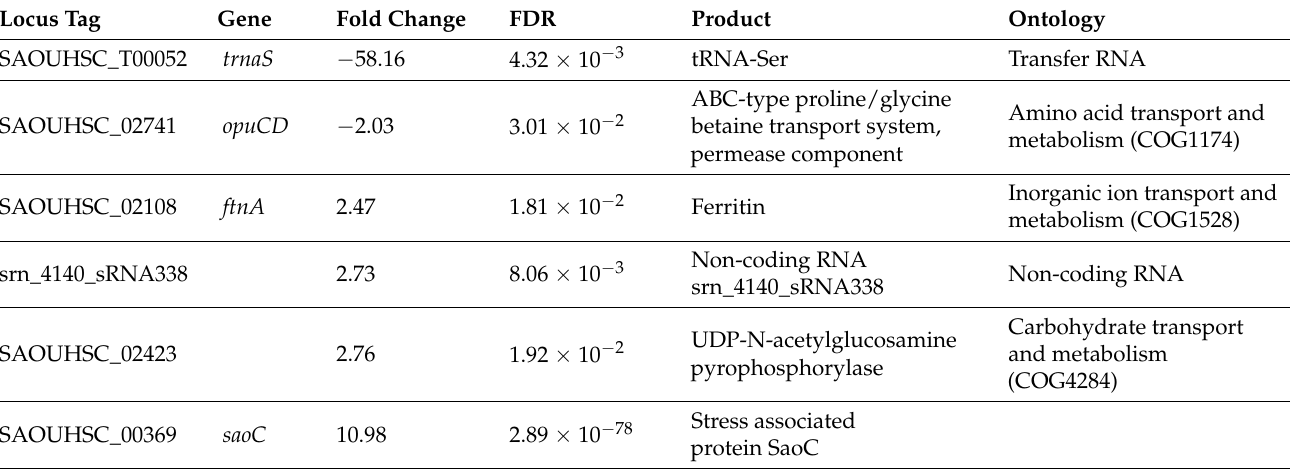
Table 2. Transcripts differentially expressed in RN4220 ∆ saoC mutant in the late growth phase. Transcripts are sorted in respect to the fold change value. Negative values indicate fold-decrease in transcription. FDR, false discovery rate ( p value adjusted with Benjamini and Hochberg method). Ontologies are determined based on the transcript type (non-coding RNA, transfer RNA) and COG database (COG IDs given in